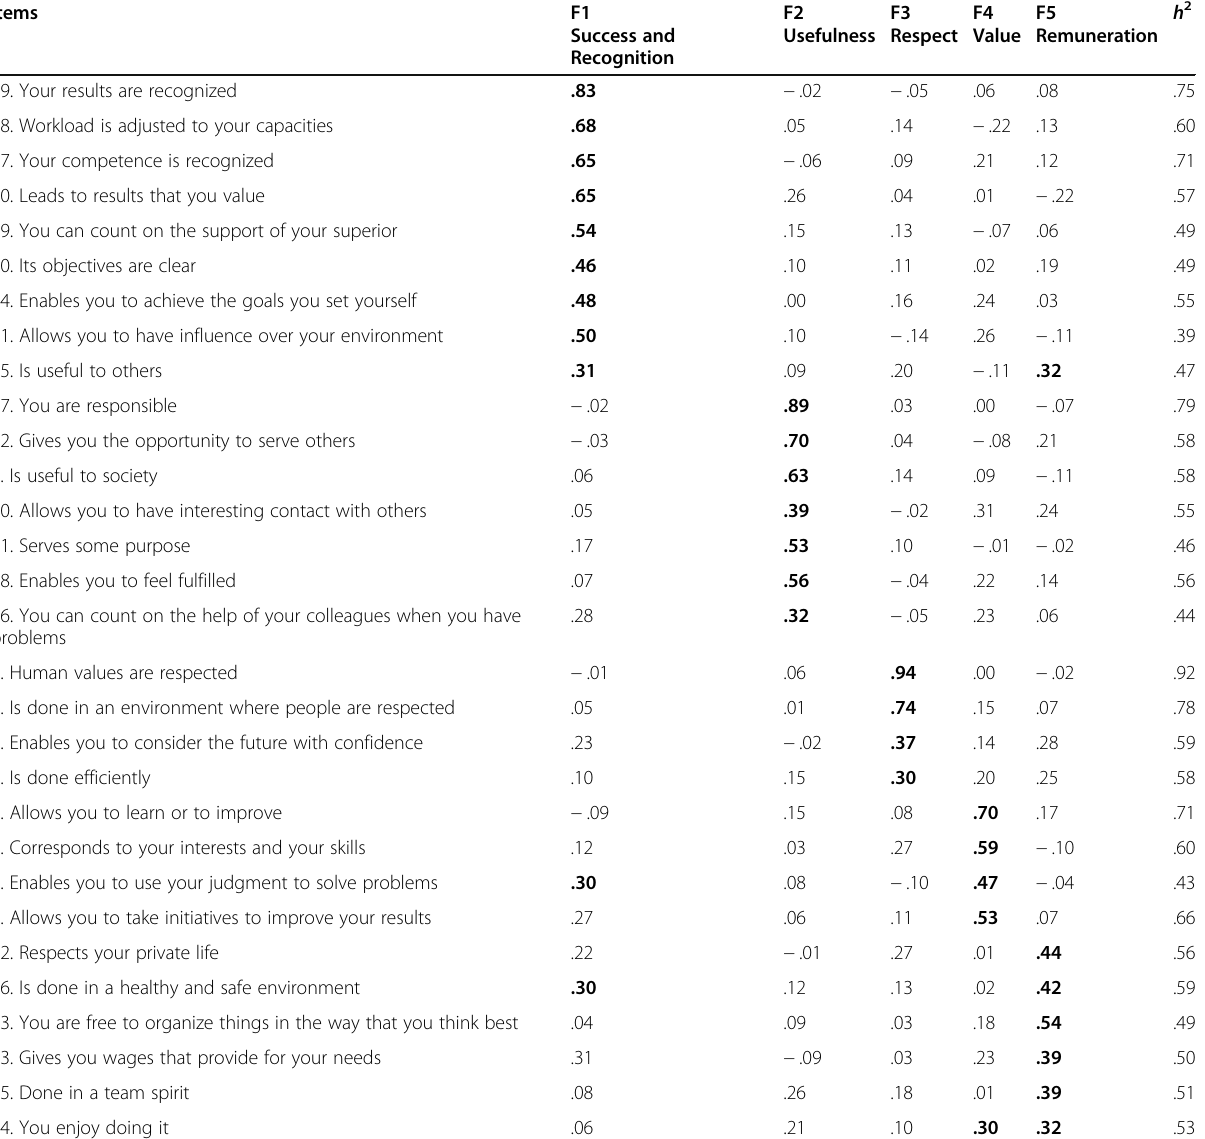
Table 5 Loadings and communalities of the 30 items from the meaning of work scale Items